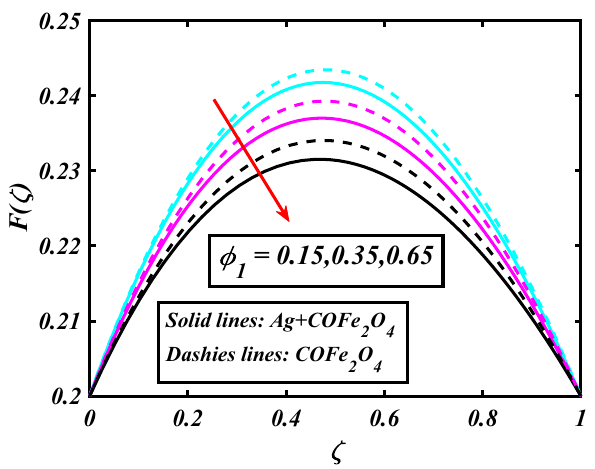
Figure 2. Demonstration of φ 1 through F (ζ)